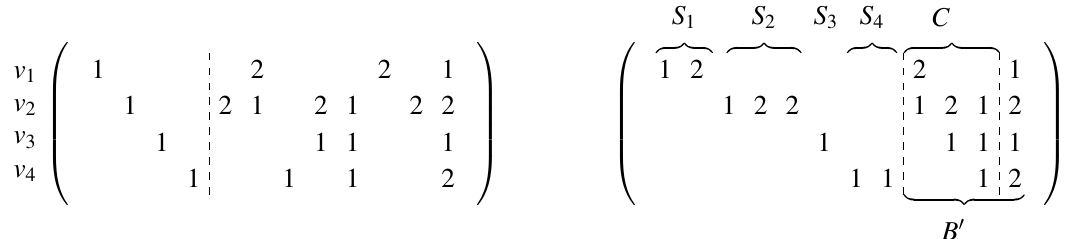
Figure 1: On the left, a matrix M over F 3 , where blank entries denote 0. On the right, we rearranged the columns of M for better